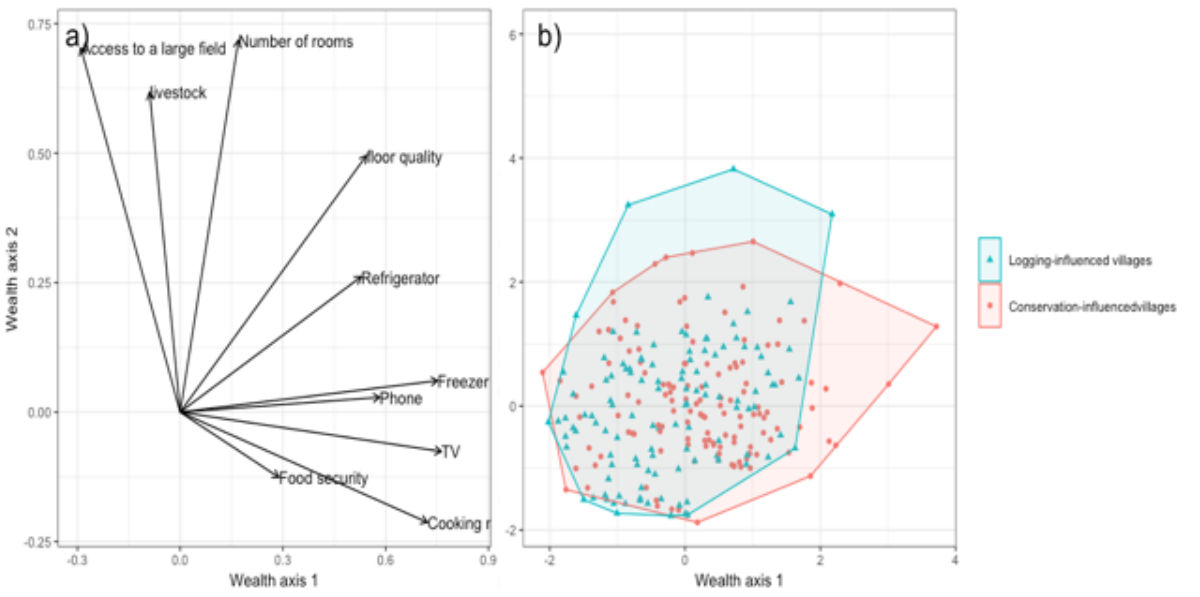
Figure A1.1: Indicators of wealth. Principal Component Analysis plots showing a) loadings of measures of wealth and b) individual scores with a convex hull for each study area. Wealth axis 1 represents consumer gods such as freezer, phone TV and cooking materials while wealth axis 2 distinguishes between households with more rooms, more livestock and those who have access to a large field (as opposed to gardens)